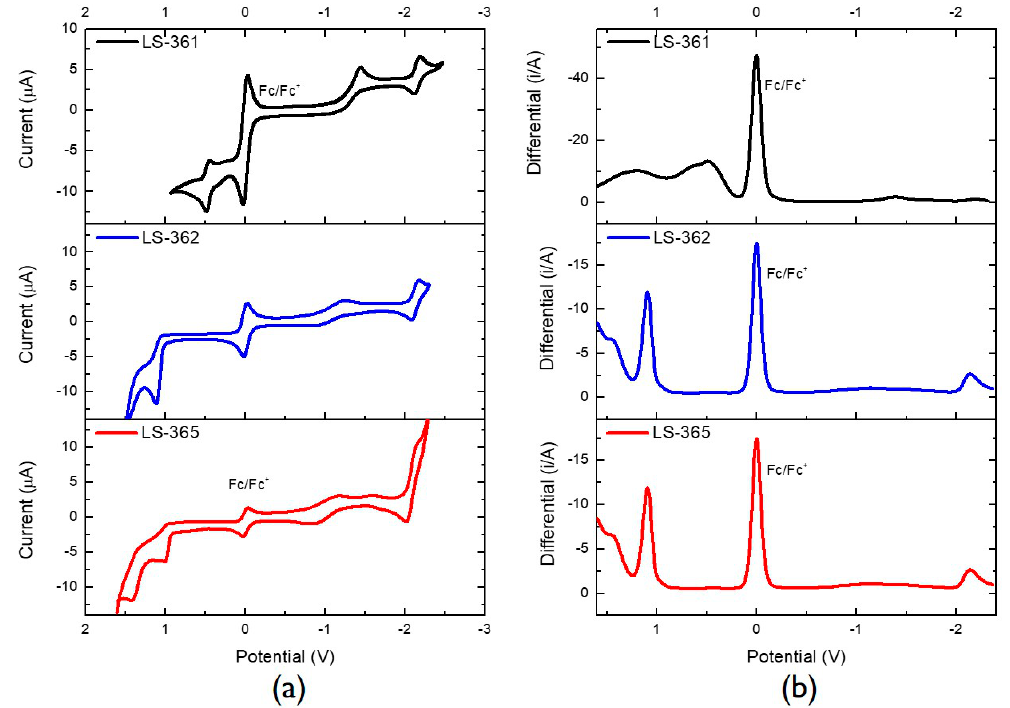
Figure 2. ( a ) Cyclic voltammetry (CV) and ( b ) square wave voltammetry (SWV) plots of LS-361 , LS-362 , and LS-365 dyes recorded in DMF (1.0 × 10 − 3